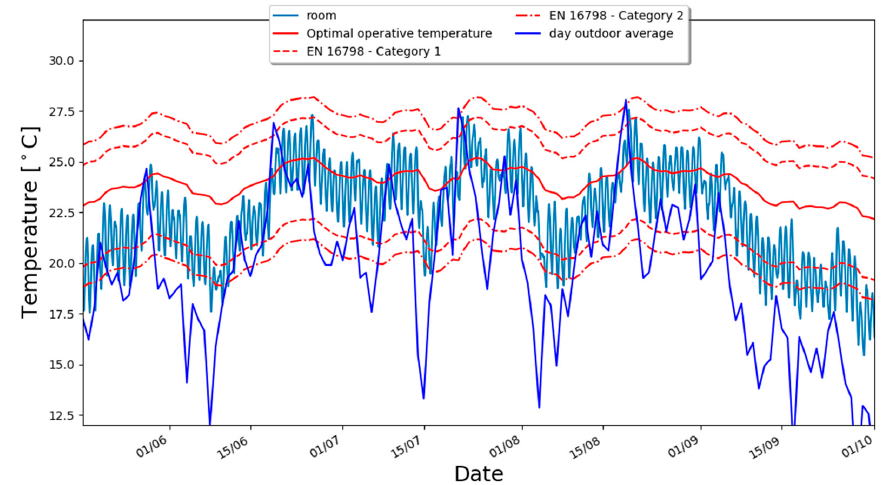
Figure 8. Temperature in the living room during the non-heating season; high-emitting configuration.